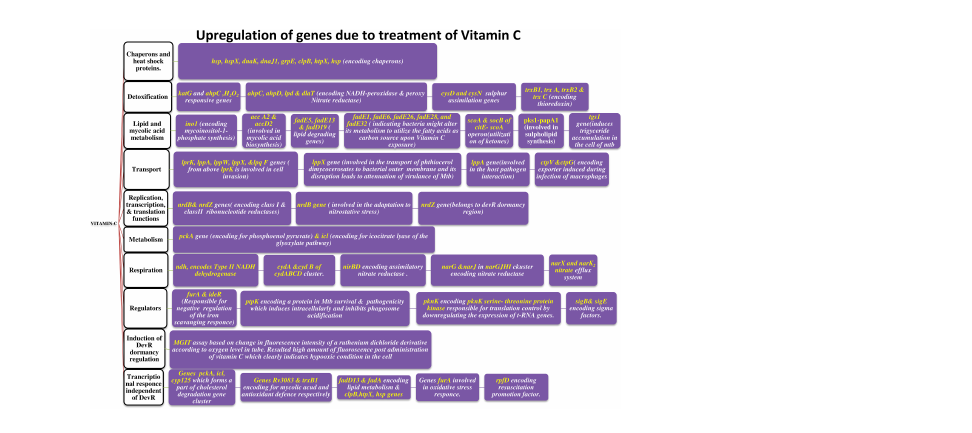
FIGURE 5 The effect of VC induced Fenton reaction on the